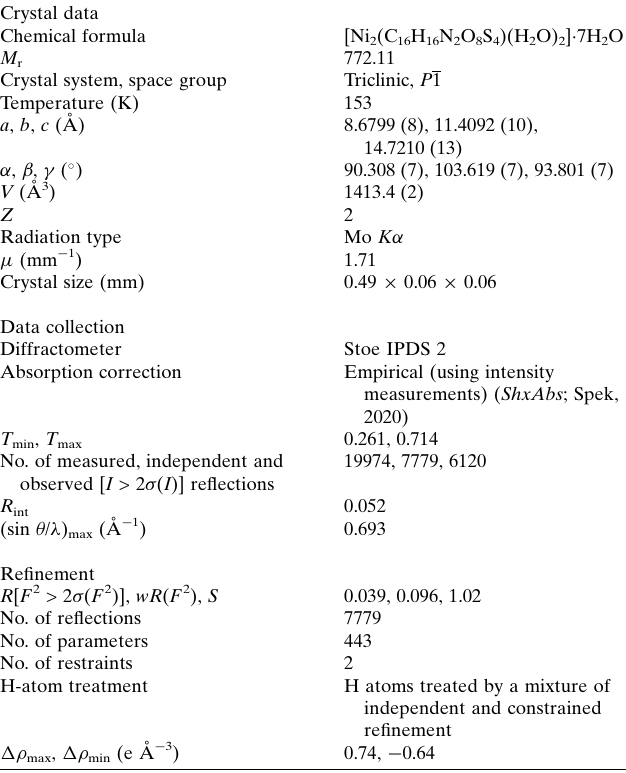
Table 3 Experimental details. Crystal data Chemical